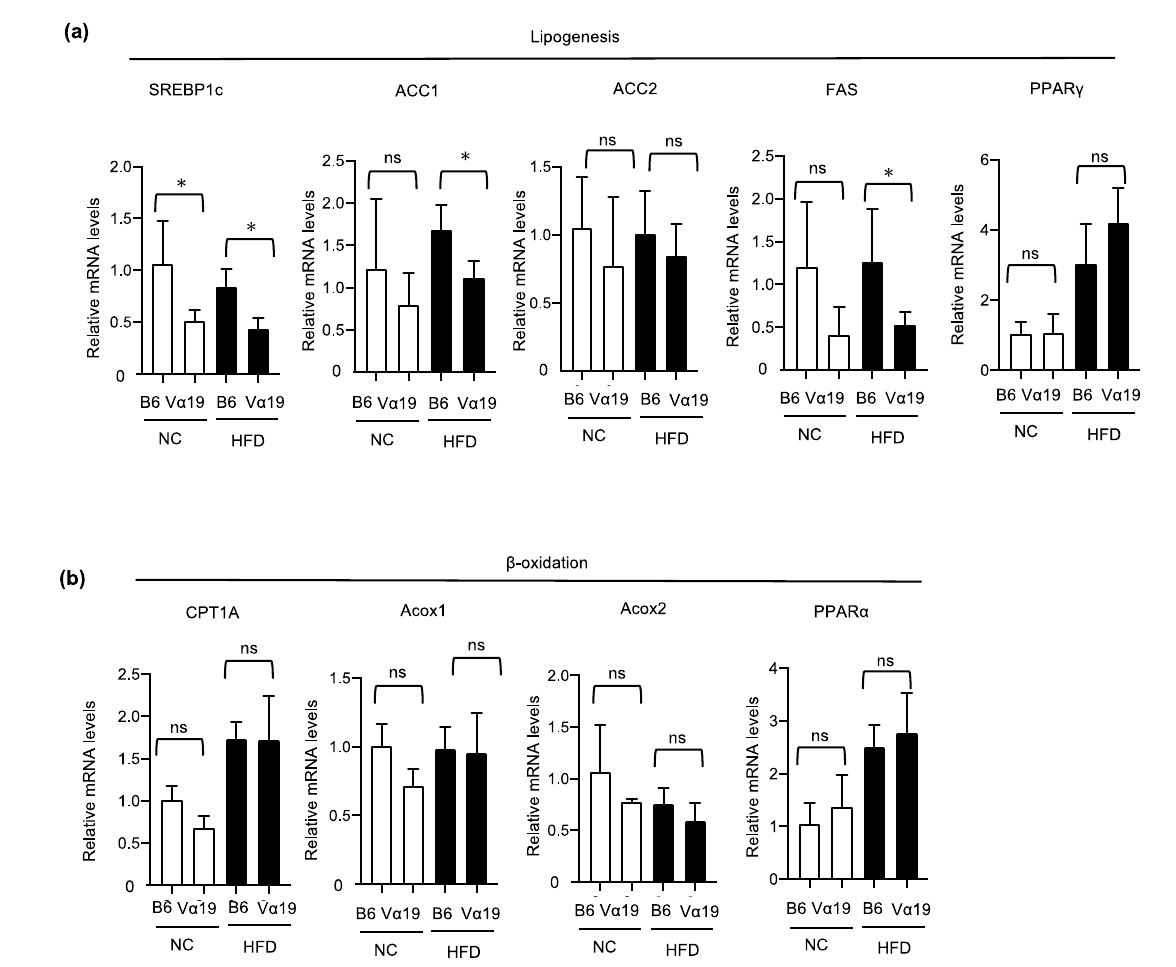
Figure 3. Lipogenesis-related genes were decreased in V α 19 mice fed a high-fat diet. ( a , b ) mRNA levels for lipogenesis- ( a ) or β -oxidation-related genes ( b ) in the liver from V α 19 mice (V α 19) and C57BL/6 mice (B6) at 27 weeks of age fed normal chow (NC) and a high-fat diet (HFD). Data on each mRNA were normalized according to the 36B4 mRNA level. The results are shown as the mean ± SD for 4 to 6 mice per group. * p < 0.05, ns, not statistically significant.